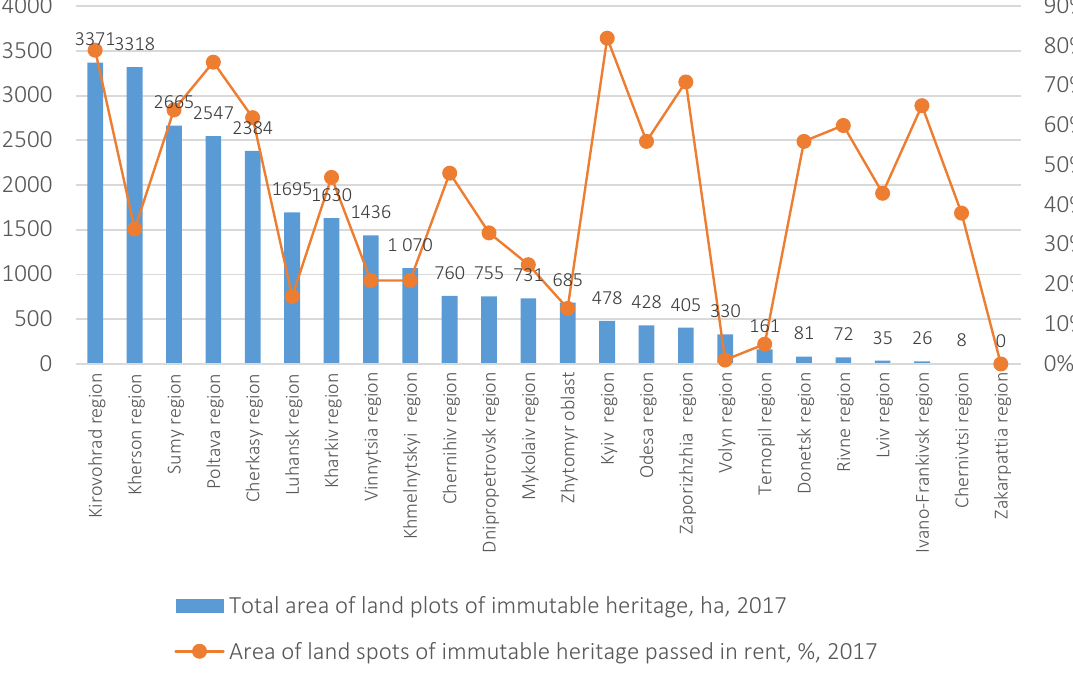
Figure 4. Comparison of land plots, which belong to immutable heritage, passed to rent through the